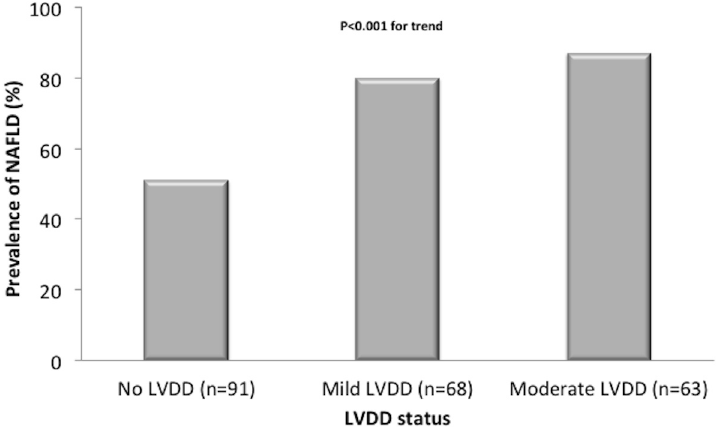
Fig 1. Prevalence of NAFLD in relation to echocardiographic grades of left ventricular diastolic dysfunction (LVDD) in patients with type 2 diabetes. P -value < 0.001 for the trend among the three groups of patients (as assessed by the χ 2 test).